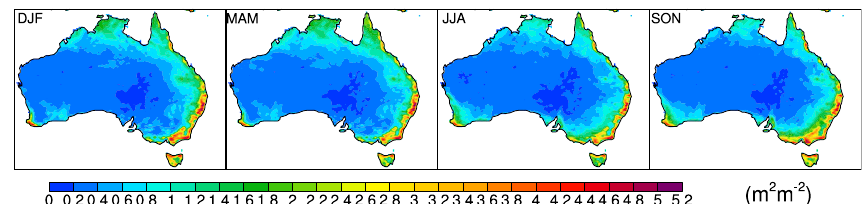
Figure 3. Seasonal mean LAI from Yuan et al. (2011) (monthly means are used in the simulations).